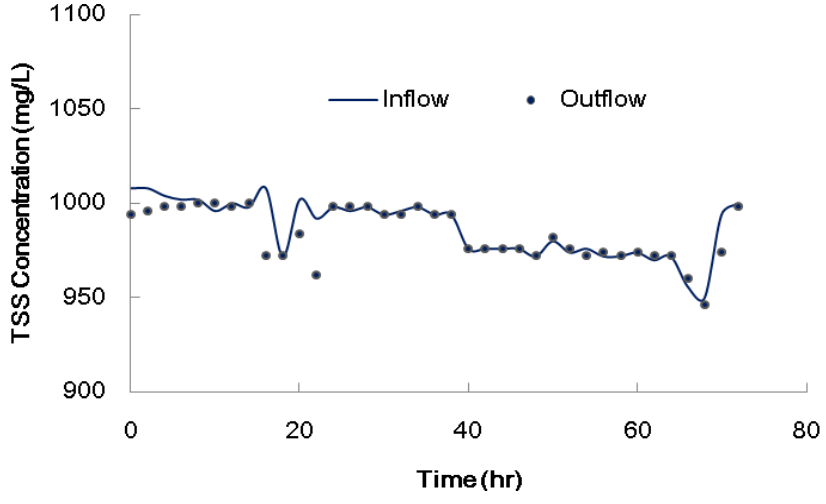
Figure 8. TSS concentration of inflow and outflow (Exp.